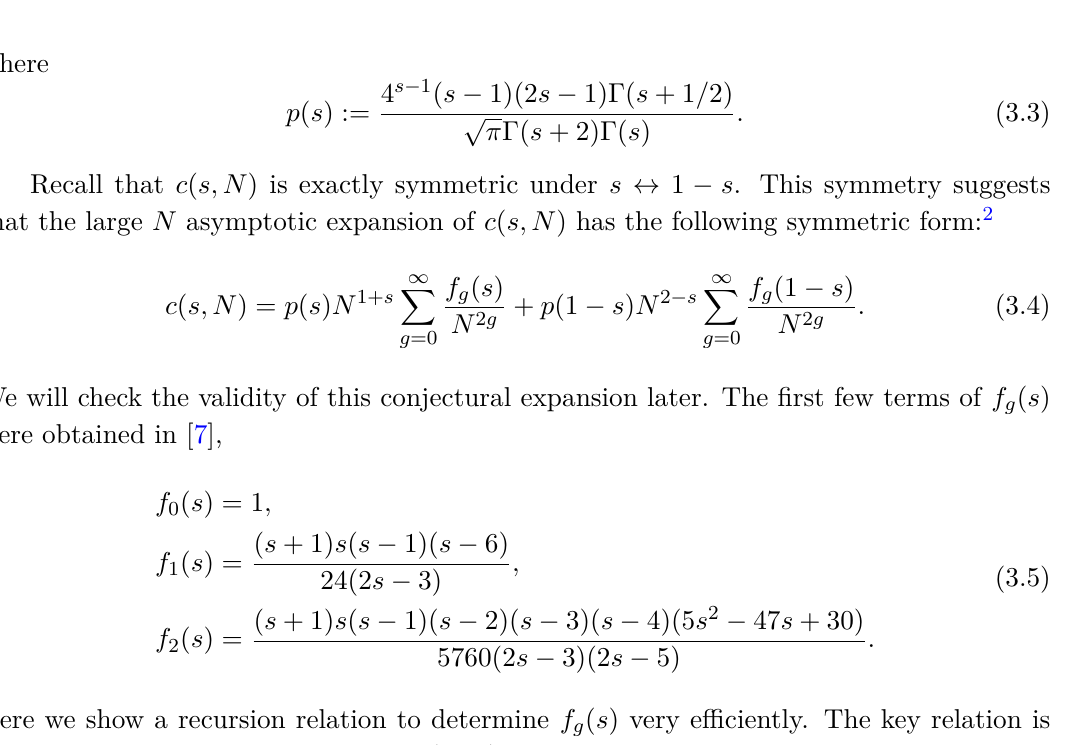
Figure 2. Plot of c ( s, N ) . The blue solid curve is the exact result of c ( s, N ) while the red and green dashed curves represent p ( s ) N 1+ s and p (1 − s ) N 2 − s , respectively. In this figure we set N = 15